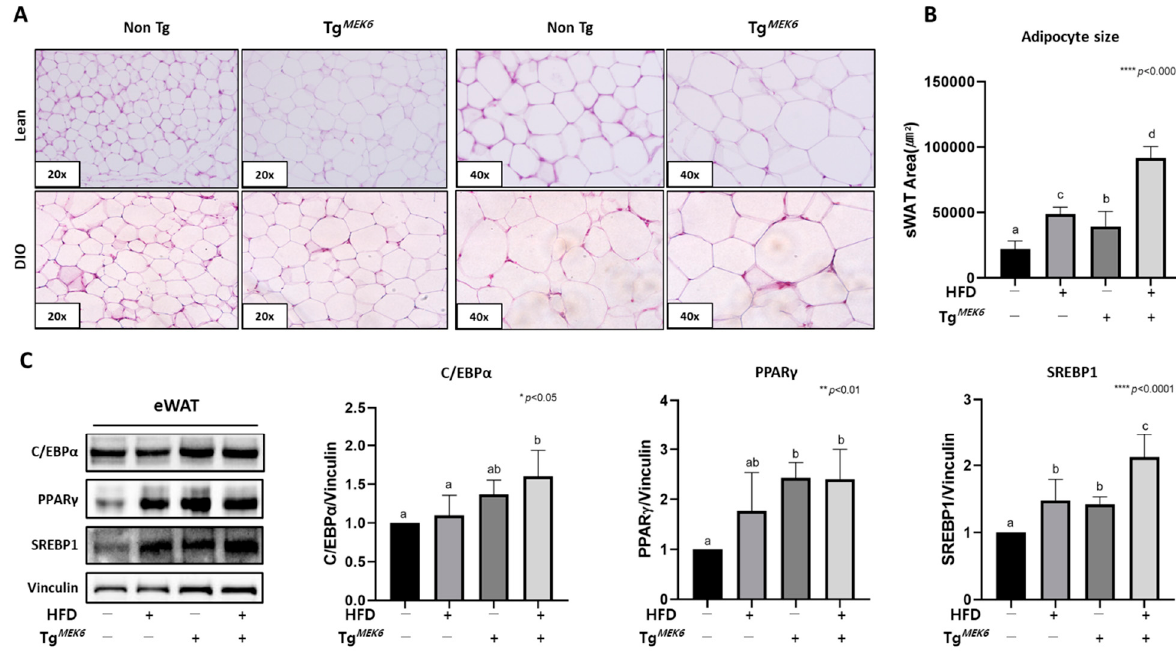
Figure 3. MEK6 overexpression of WAT was increased adipocyte hypertrophy and adipogenesis in C57BL/6 mice. ( A ) Representative sections of H&E staining show the adipocytes in sWAT (subcutaneous fat); 20×, 40× magnification ( B ) Quantification of adipocyte size in sWAT. ( C ) The expression of proteins related to adipogenesis (C/EBP α , PPAR γ ) and cholesterol synthesis (SREBP1) in eWAT (epididymal fat). Results are expressed as mean ± SD. Data were assessed by one ‐ way ANOVA with Duncan’s test (NS, not significant by unpaired t ‐ test. *; p < 0.05, **; p < 0.01, ****; p < 0.0001). Superscript letters (a, b, c, d) indicate the significant differences between the groups at p < 0.05. +, treatment or transfection; − , non ‐ treatment or non ‐ transfection.